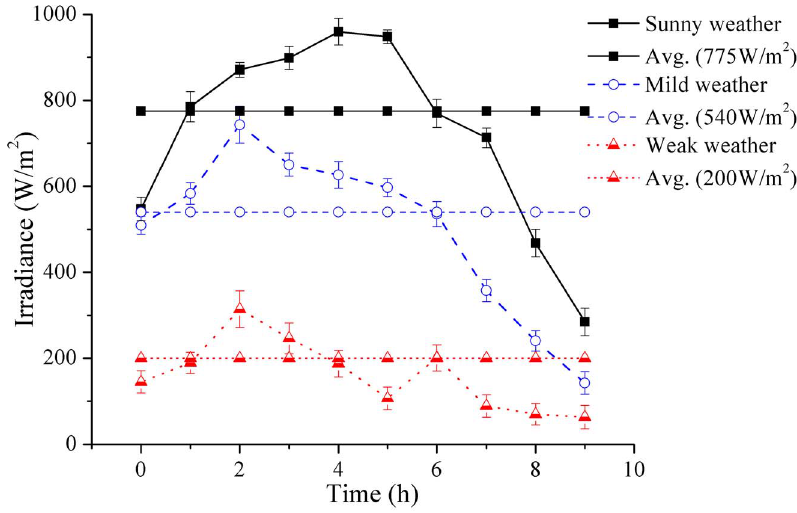
Figure 2. Irradiance change under different weather conditions.